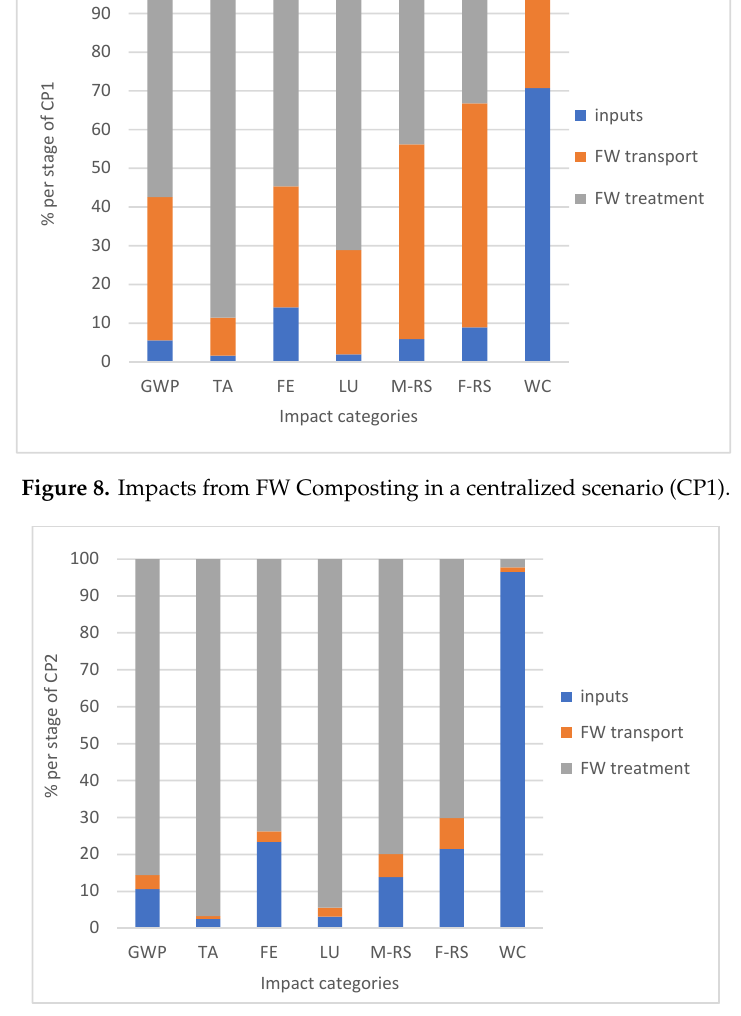
Energies 2020 , 13 , x FOR PEER REVIEW Figure 9. Impacts from FW Composting in a centralized scenario (CP2). Figure 9. Impacts from FW Composting in a centralized scenario (CP2). Figure 9. Impacts from FW Composting in a centralized scenario (CP2).